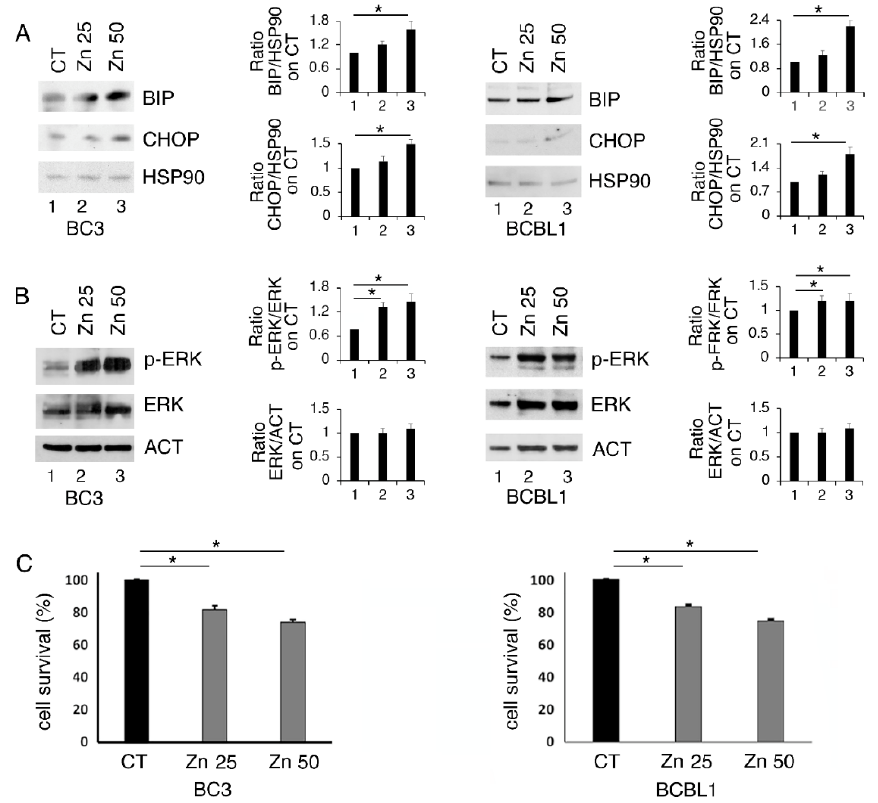
Figure 1. Zinc upregulates BiP and slightly CHOP and increases ERK1/2 phosphorylation in BC3 and BCBL1 cells. BC3 and BCBL1 were untreated (CT) and treated with 25 and 50 µM Zinc (Zn) and the expression level of BiP and CHOP ( A ) and phospho- and total ER1/2 ( B ) were evaluated by Western blot analysis. Densitometric analysis was performed as reported in material and methods. ( C ) BC3 and BCBL1 cells were treated with 25 and 50 µM Zinc (Zn) and cell survival was evaluated by trypan blue assay after 24 h of treatment, % of cell survival is shown. The histograms represent the mean plus S.D. from three experiments. * p -value < 0.05.